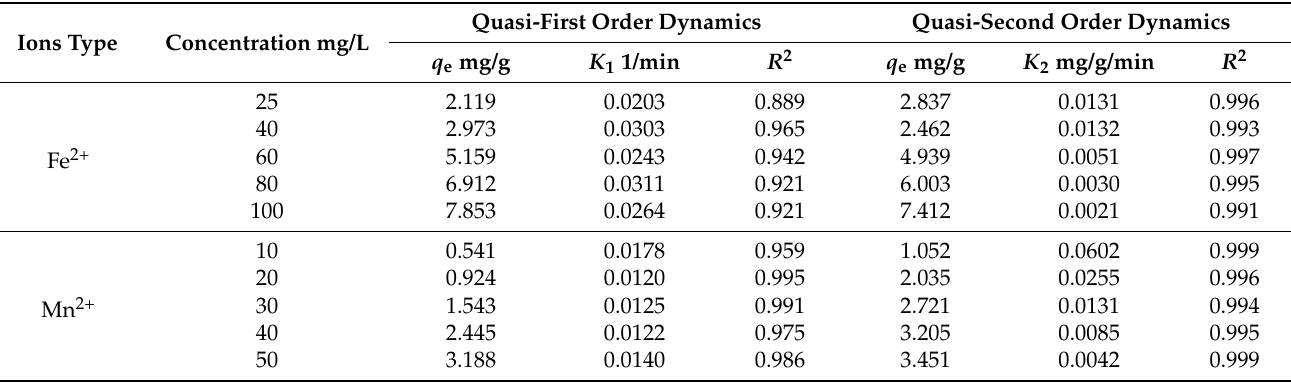
Table 3. Pseudo-first order and pseudo-second order kinetic fitting